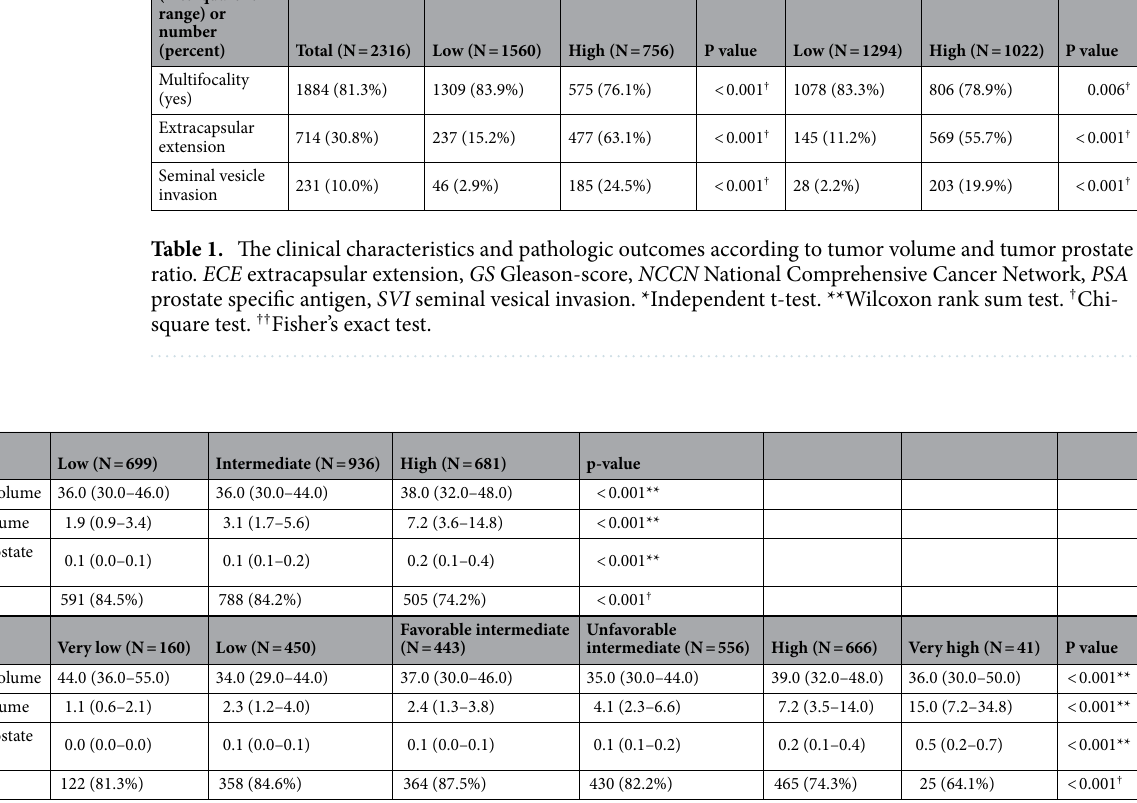
Table 2. Mean tumor volume difference according to NCCN and D’Amico risk classification. NCCN National Comprehensive Cancer Network, RP radical prostatectomy. *Independent t-test. **Wilcoxon rank sum test. † Chi-square test. †† Fisher’s exact test.